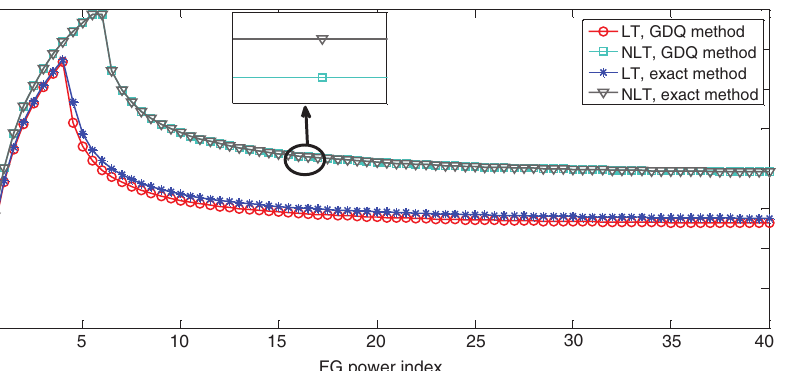
Figure 3: Comparison of the GDQM and analytical method in the model with and L = 10 μ m, L/R = 10, h/R = 0.1, l = 2 × 10 10 , K = 100, Δ T = 200, C K w p